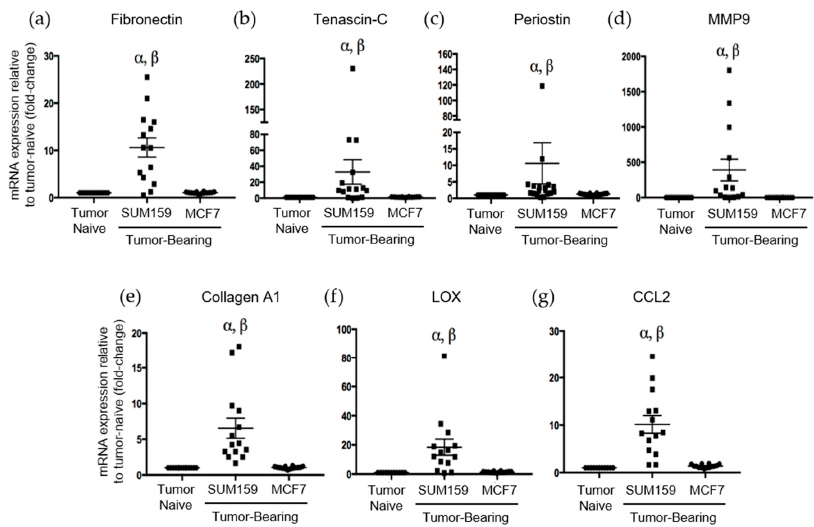
Figure 4. Mice bearing triple negative SUM159 tumors demonstrate increased mRNA expression of the premetastatic markers fibronection, tenascin-c, periostin, MMP9, collagen A1, LOX and CCL2 in the lungs. Triple-negative SUM159 or luminal A MCF7 human breast cancer cells were injected into the mammary fat pad of female nude mice, and primary breast tumors were allowed to develop up to a mean tumor size of 1500 mm 3 . Animals were euthanized at the endpoint, and lungs were harvested and snap-frozen. RNA was isolated from lungs and subjected to qRT-PCR analysis to assess the expression of murine fibronectin ( a ), tenascin-c ( b ), periostin ( c ), MMP9 ( d ), collegen A1 ( e ), LOX ( f ) and CCL2 ( g ) ( n = 15 mice/group). Data are presented as the mean ± SEM. α = significantly different from age-matched tumor-naïve controls. β = significantly different from MCF7 tumor-bearing mice ( p < 0.005).